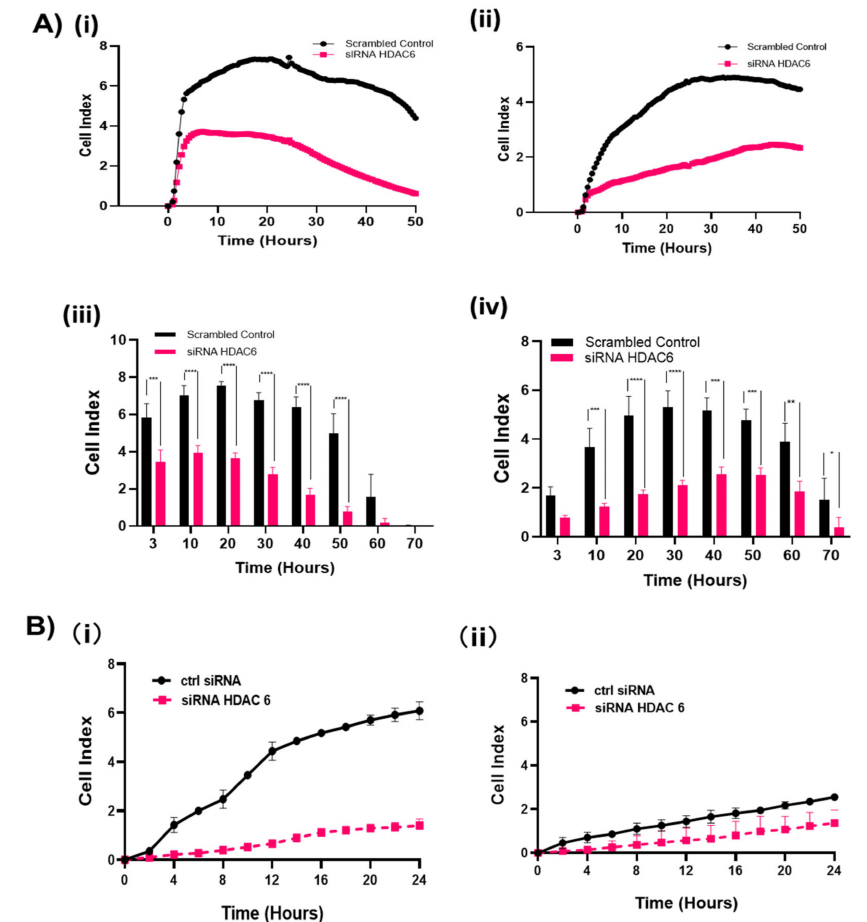
Figure 3. siRNA-mediated knockdown of HDAC6 caused lower cell spreading, cell proliferation, and cell migration. Cells were transfected with HDAC6 siRNA or negative scrambled control for 48 h followed by continuous measure of cell index by xCELLigence system. ( A ) / ( i ),( ii ) Representative graphs from the real time xCELLigence proliferation system comparing growth profiles of scrambled siRNA treated SMG cells and HDAC6 transfected SMG cells. ( A ) / ( iii ),( iv ) Cell index values taken from the xCELLigence system monitoring the cells at time intervals, observing the rate of adhesion / spreading (3 h) and proliferation (6–70 h). Wells were analyzed in duplicate, and two biological replicates were performed to validate results, n = 2. Experiments were analyzed by a two-way ANOVA. * p < 0.05, ** p < 0.01, *** p < 0.001, **** p < 0.0001. ( A ) / ( i ),( ii ) SMG5, ( A ) / ( iii ),( iv ) SMG6. ( B ) Migration assay with SMG5 cells ( B ) / ( i ) and SMG6 cells ( B ) / ( ii ) measured continuously as cell index using the migration xCELLigence system following siRNA transfection. Wells were analyzed in duplicate and two biological replicates were performed to validate